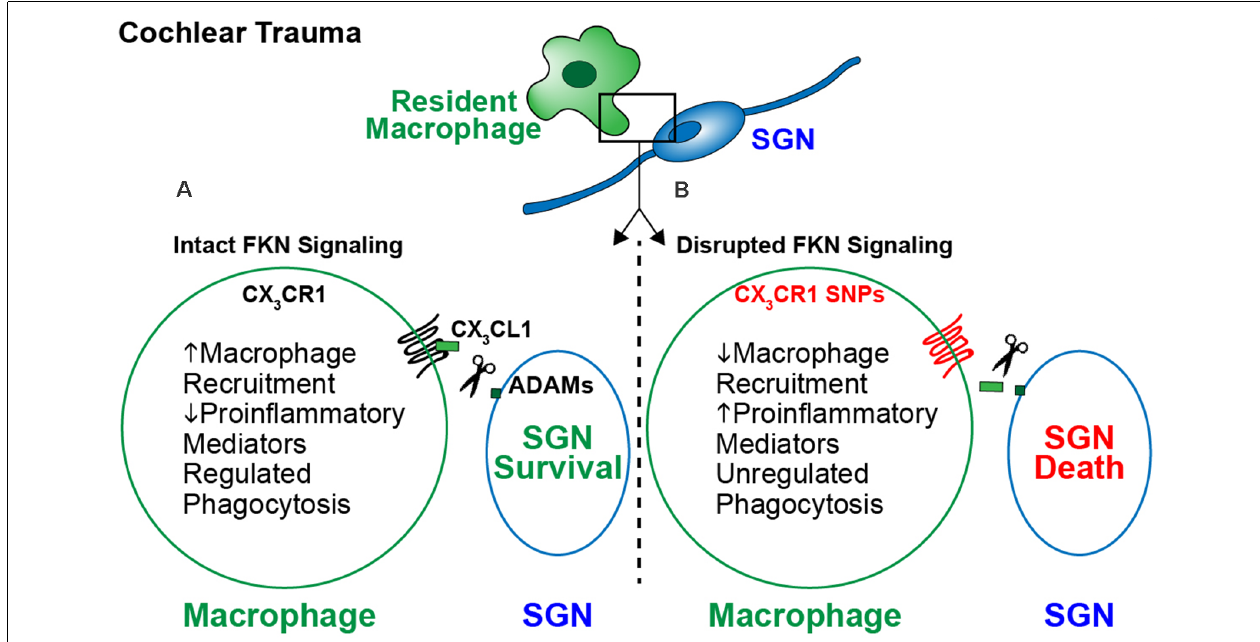
FIGURE 3 | The proposed model for fractalkine-mediated neuroprotection after cochlear injury. Following cochlear damage there is a sustained increase in the numbers of macrophages in the spiral ganglion. This increase in numbers is likely due to infiltration of blood-derived macrophages from the vasculature. (A) Following cochlear trauma, CX 3 CL1 is proteolytically cleaved from SGNs/IHCs and soluble CX 3 CL1 binds to its unique receptor CX 3 CR1 expressed by macrophages. Activation of fractalkine signaling induces an immune response characterized by recruitment of anti-inflammatory and pro-healing macrophages from the vasculature into the injured cochlea, regulation of cochlear inflammation, and preserved SGNs. (B) When FKN signaling is disrupted, i.e., due to loss of function in humans carrying CX3CR1 polymorphisms, there is a lack of macrophage recruitment and a sustained proinflammatory state following trauma. This results in SGN death, due to unregulated inflammation and phagocytosis by